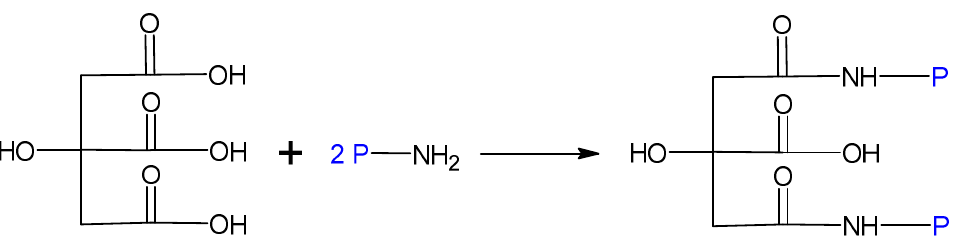
Figure 4. Schematic representation of the cross-linking between citric acid and protein, where “NH2-P” represents the protein.